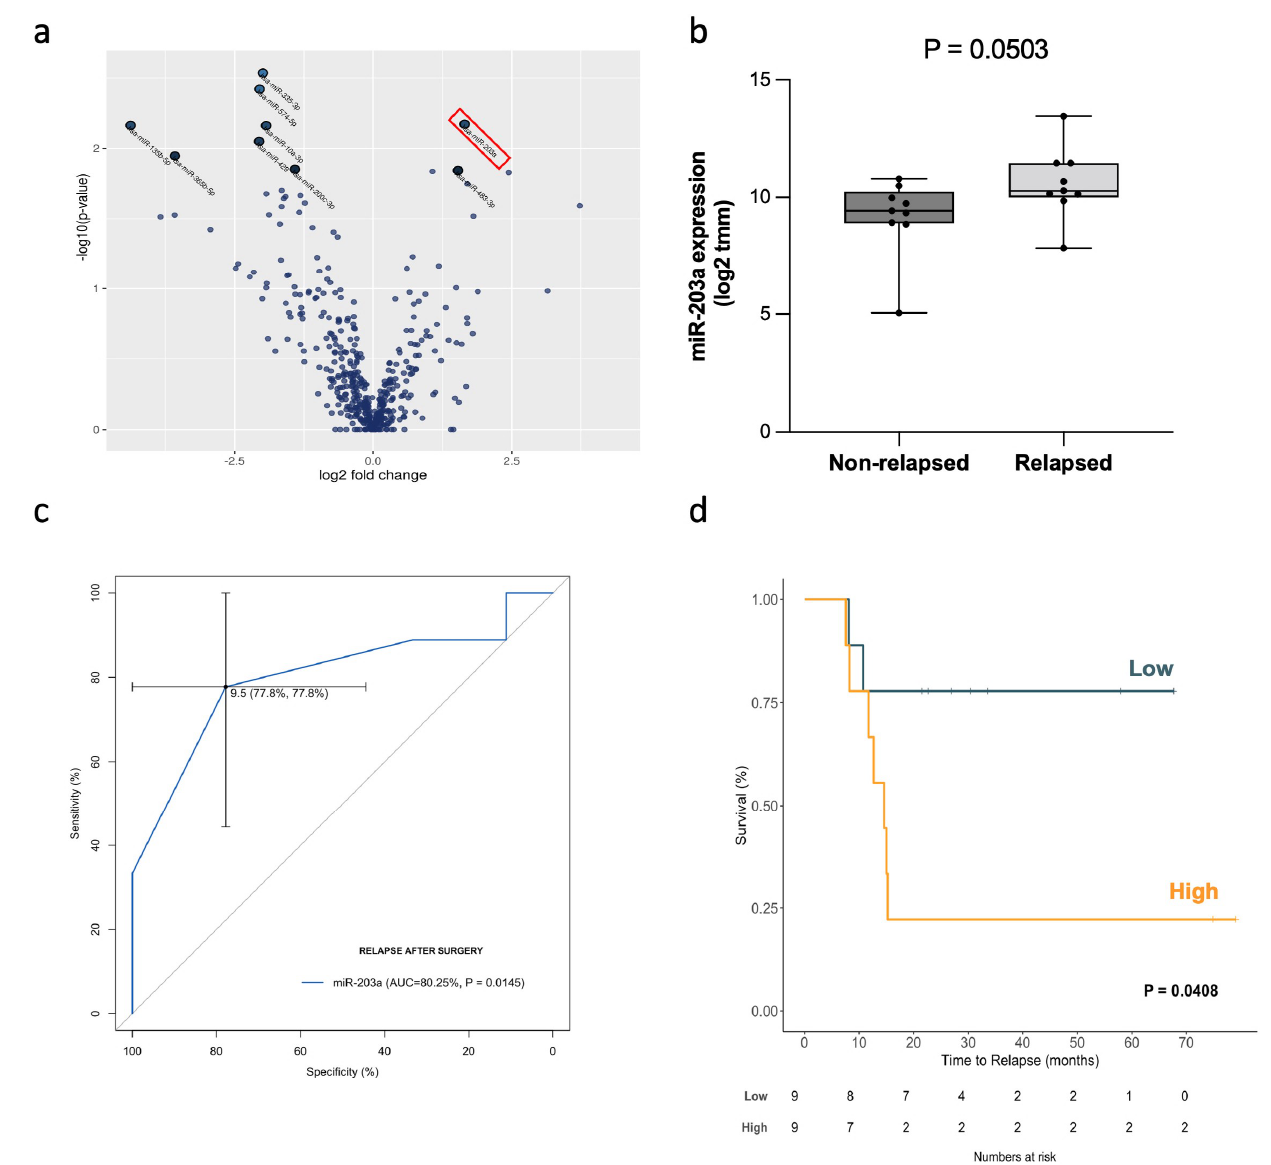
Figure 3. TDV EV-miR-203a-3p was identified as a candidate relapse biomarker: ( a ) Volcano plot of miRNAs differentially expressed in pulmonary TDV EVs from relapsed and non-relapsed NSCLC patients. EV-miR-203a-3p (highlighted with a red box) was the most upregulated miRNA in relapsed patients. ( b ) Boxplot showing TDV EV-miR-203a-3p levels (log2 TMM) in non-relapsed and relapsed patients from the screening cohort. The p -value shown has been calculated using the Mann–Whitney U test. ( c ) ROC curve analysis of pulmonary TDV EV-miR-203a-3p, predicting relapse after surgery in the screening cohort of NSCLC patients. ( d ) Kaplan–Meier survival analysis of pulmonary TDV EV-miR-203a-3p and TTR in the screening cohort of NSCLC